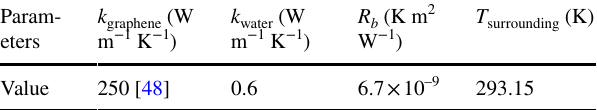
Table 2 The parameters used in finite element simulation by COM- SOL Param-